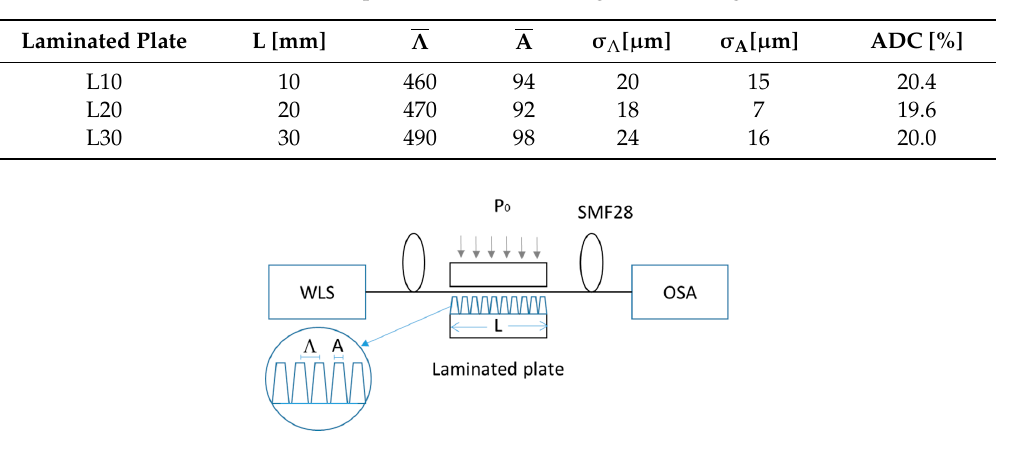
Table 1. Laminated plates constructed: Length and average values.